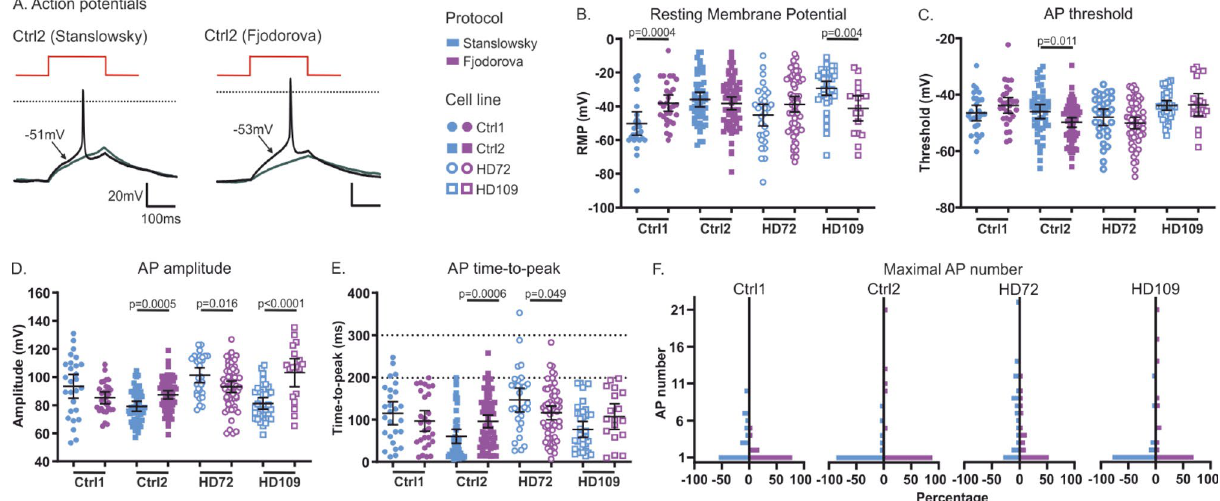
Figure 7. hiPS cell-derived neurons display distinct AP features within the two protocols. ( A ) Representative AP traces (black) of Ctrl2 neurons from Stanslowsky (left) and from Fjodorova (right) protocols. The grey trace represents the subthreshold current injection step. AP threshold for each individual neuron is indicated with an arrow. The red trace indicates the current injection step. Dotted black lines represent 0 mV. ( B ) Resting membrane potential (RMP). ( C , E ) AP features of control/HD hiPS cell-derived neurons from the Stanslowsky protocol (blue, n = 27 Ctrl1, 46 Ctrl2, 30 HD72 and 37 HD109 neurons) and the Fjodorova protocol (purple, n = 29 Ctrl1, 65 Ctrl2, 57 HD72 and 18 HD109 neurons): AP threshold ( C ), AP amplitude ( D ) and AP time- to-peak ( E ). Two dotted lines indicate the cut-off of neurons with a time-to-peak longer than 200 or 300 ms. ( F ) Maximal number of APs fired by control and HD neurons. Data show mean ± 95% CI. See Supplementary Table S9 for statistical